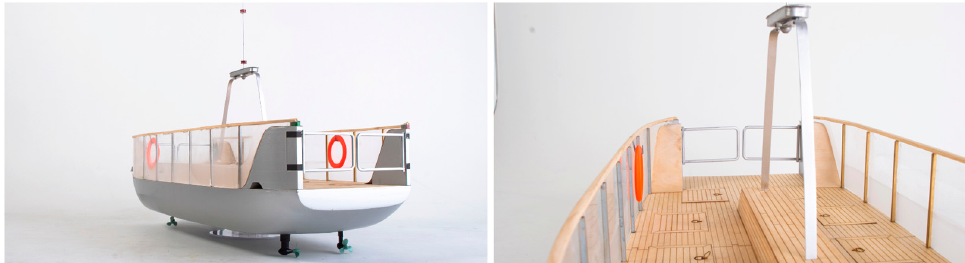
Figure 7. Design, form, and aesthetics played an important role in explaining ‘safety, stability, and friendliness’ to ASV passengers, according to user research done by [40] (Images depict a 1:10 scale model of milliAmpere2; Reproduced with permission from Petter Mustvedt, published by NTNU Open under Creative Commons CC BY 4.0 License, 2019).